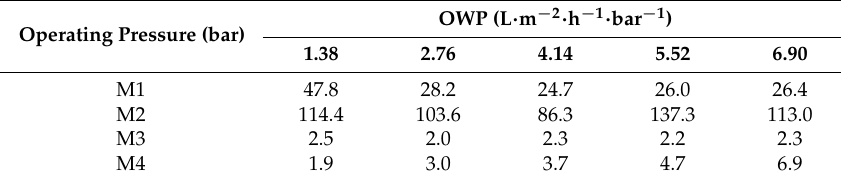
Table 3. OWP for M1, M2, M3, and M4 using deionized water.